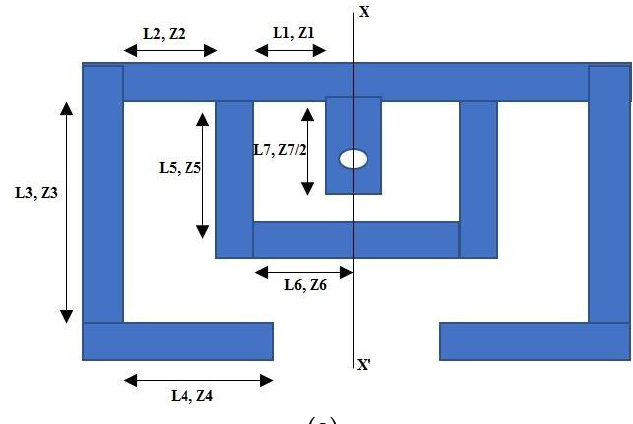
Figure 8. Control of the C-shaped resonator for the 8.3 GHz stopband.